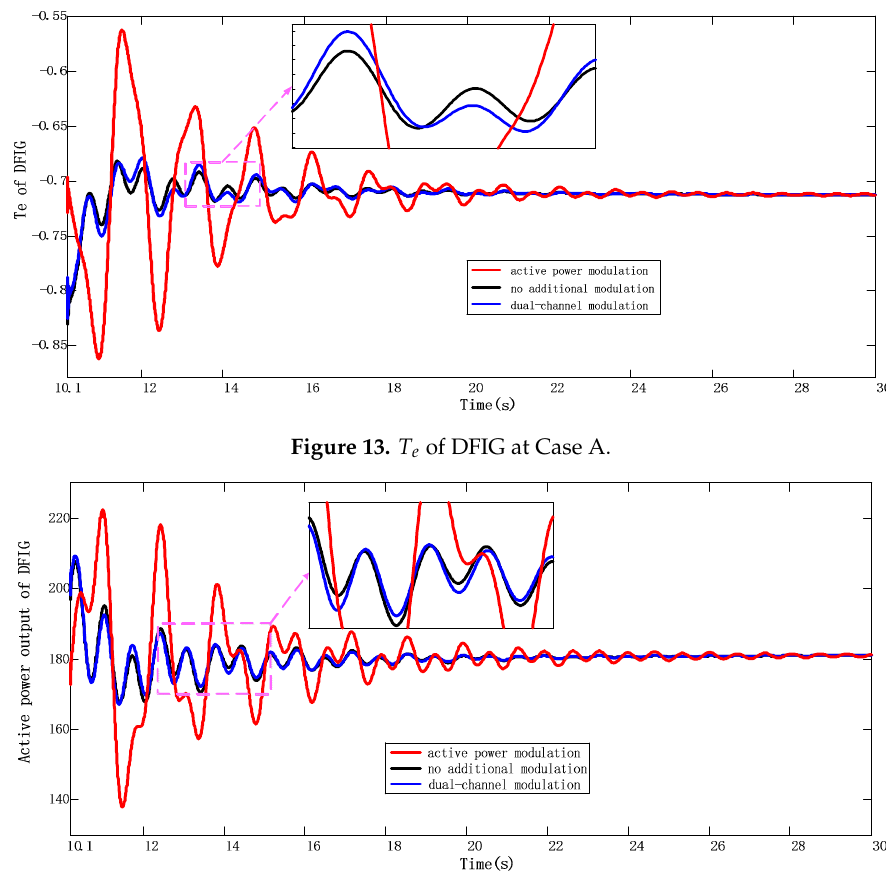
Figure 14. Active power output of DFIG at Case A.